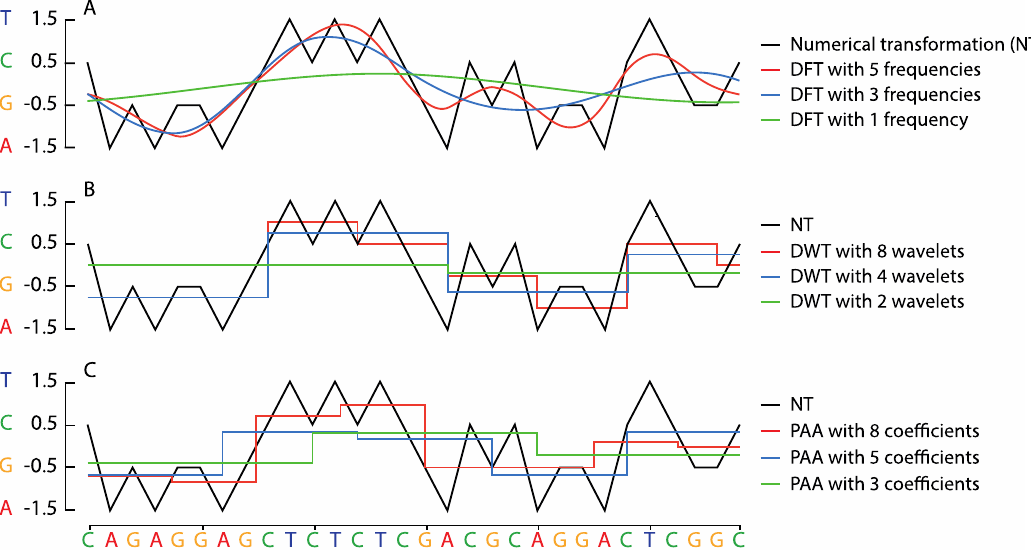
Figure 1. A numerically represented DNA sequence transformed at various levels of spatial resolution using the discrete Fourier transform (DFT) of the whole sequence ( A ), the Haar discrete wavelet transform (DWT) ( B ) and piecewise aggregate approximation (PAA) ( C ). A 30 nucleotide sequence ( x -axis) is represented as a numerical sequence (black lines) using the real number representation method ( y -axis where T = 1.5, C = 0.5, G = − 0.5 and A = − 1.5) for DFT approximations of the sequence with 5 (red), 3 (blue) and 1 (green) Fourier frequencies ( A ); DWT approximations of the same sequence with 8 level wavelets (red), 4 level wavelets (blue) and 2 level wavelets (green) ( B ); PAA approximations of the same sequence with 8 (red), 5 (blue) and 3 (green) coefficients ( C ).